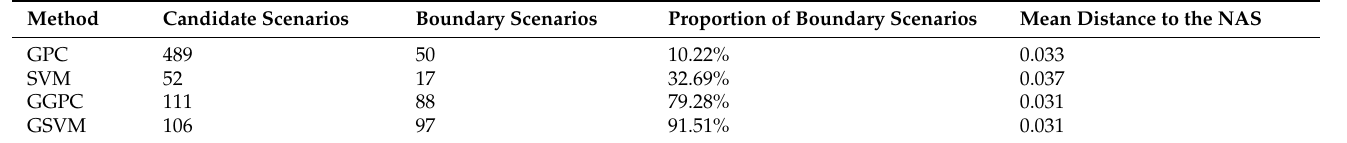
Table 9. Performance of the four classifiers in generating boundary cut-in